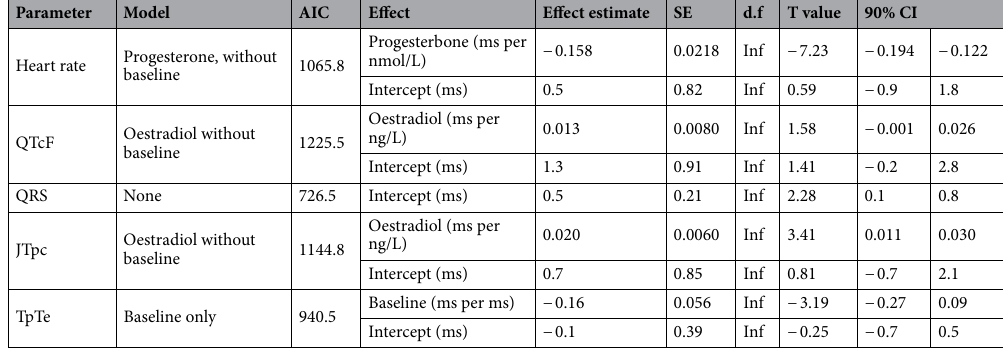
Table 4. Significant estimates of fixed effects of sex hormones on cardiac parameters. SE standard error, df degrees of